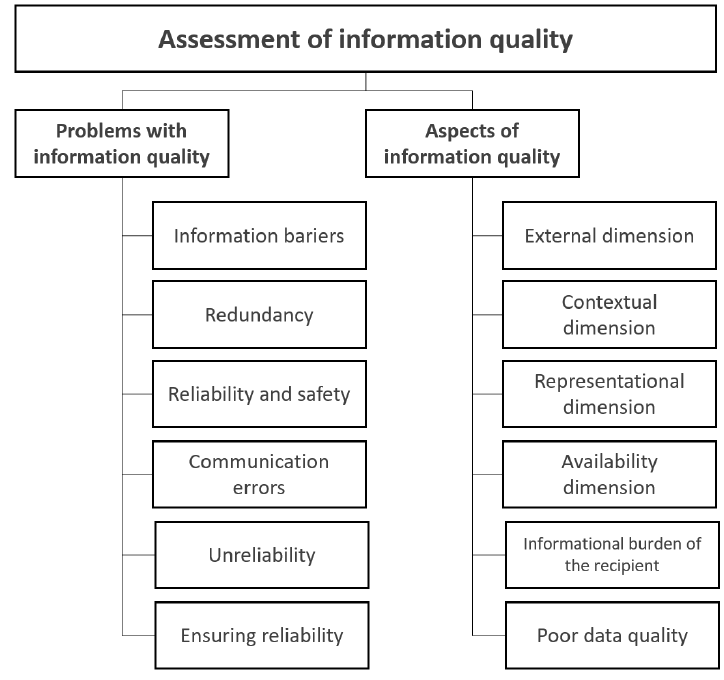
Figure 1. Scheme for assessment of information quality.